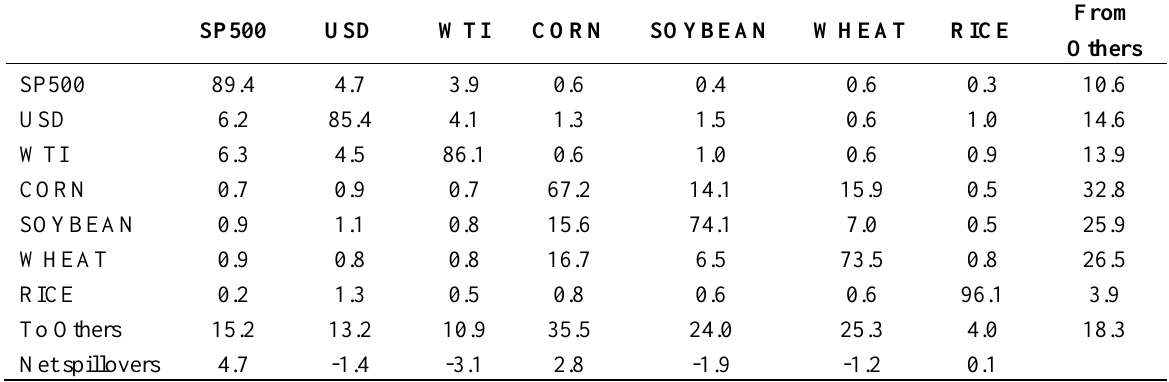
Table 1A: The direction of implied volatility spillovers (the OLS method). SP500 USD WTI CORN SOYBEAN WHEAT RICE